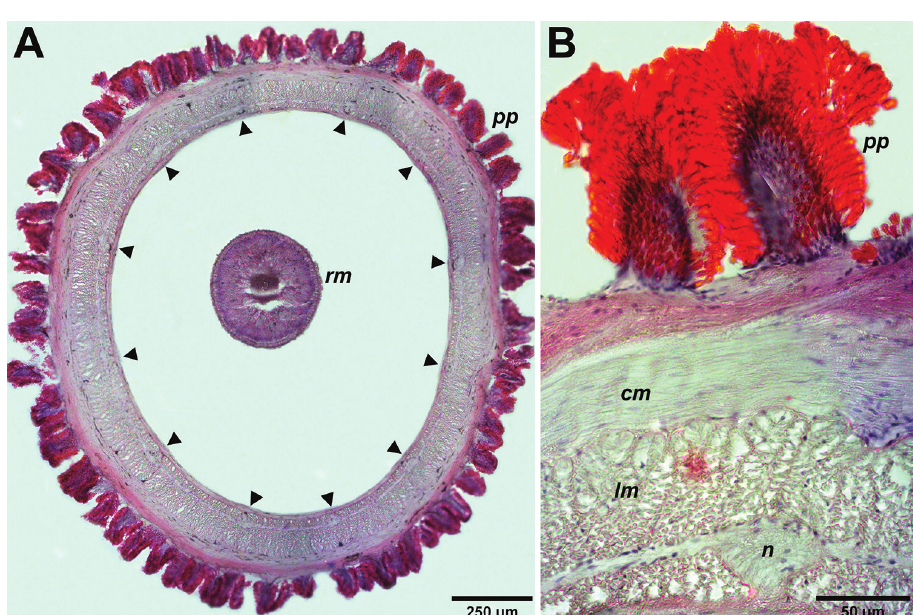
Figure 3. Nipponnemertes incainca sp. n. A Transverse sections of the proboscis; nerves are highlighted by arrowheads B Microscopic detail of transverse section showing the proboscis papillae. Abbreviations: pp pro- boscis papillae, lm longitudinal muscles, cm circular muscles, rm retractor muscles of the proboscis, n